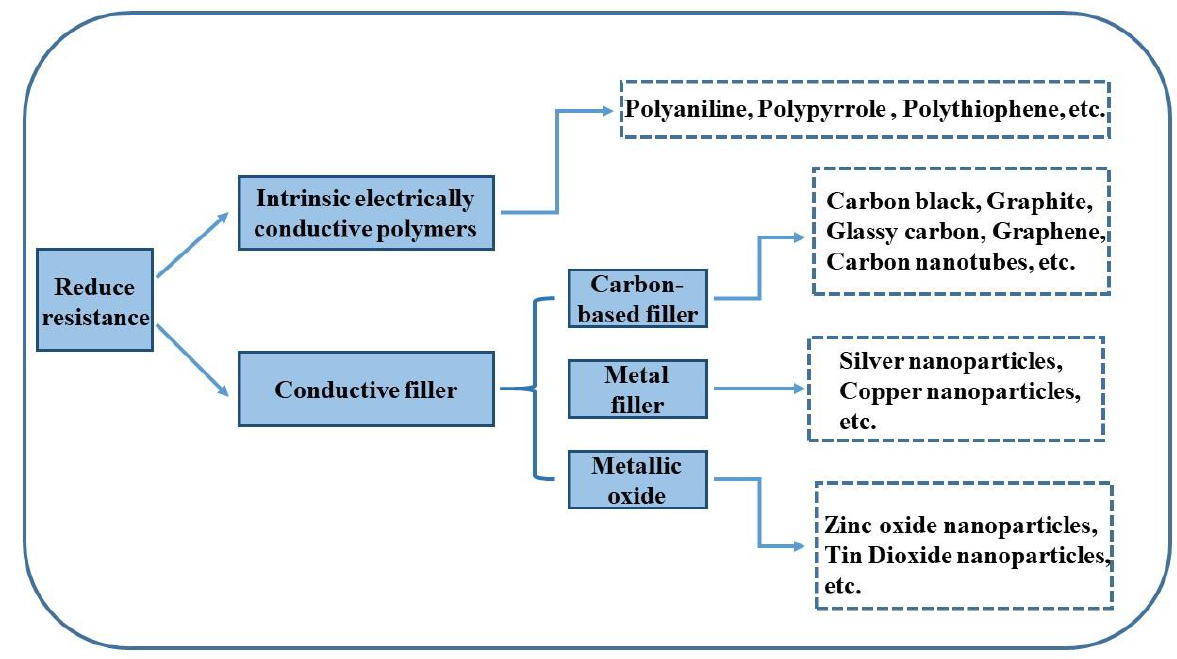
Figure 9. Strategies to reduce surface electrical resistance.